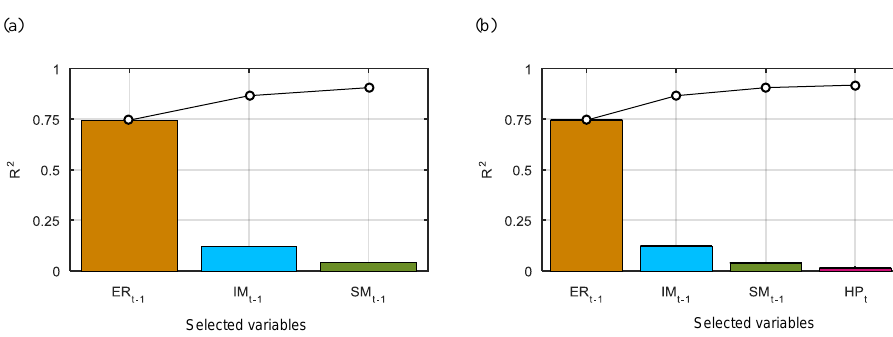
Figure 4. Results of the IIS algorithm: fraction of the variance of SSC t explained by the selected explanatory variables, and cumulative explained variance (black line with circles) of (a) the most frequently selected model (ER t − 1 , IM t − 1 , SM t − 1 ) and (b) the most frequently selected model including hydropower releases (ER t − 1 , IM t − 1 , SM t − 1 , HP t ).